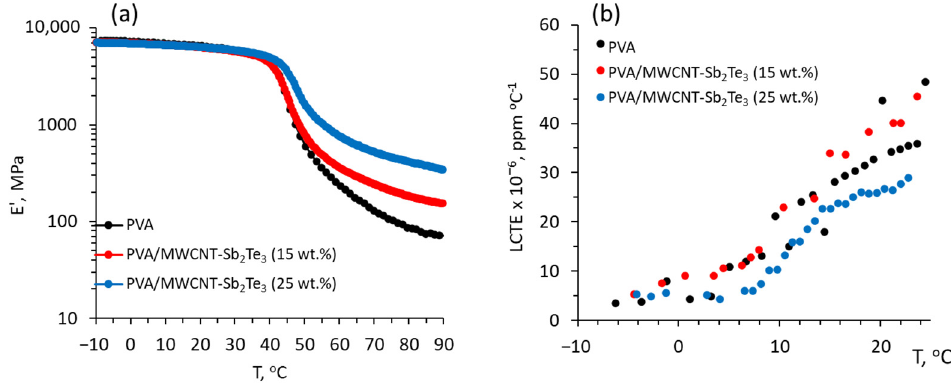
Figure 3. ( a ) storage modulus and ( b ) linear coefficient of thermal expansion (LCTE) vs. temperature of neat PVA and PVA/MWCNT ‐ Sb 2 Te 3 composites.